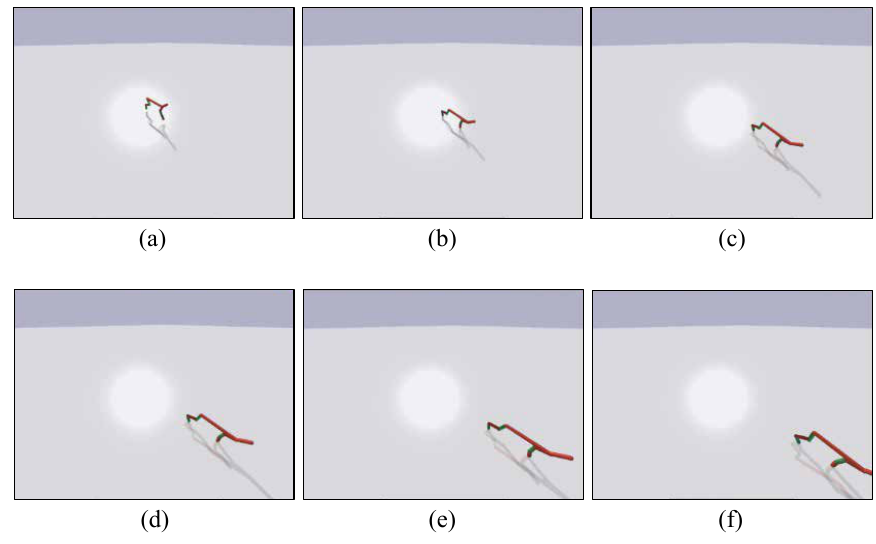
Figure 10. The visualized training result.The subgraphs ( a – f ) are captured serially during the walking task of the trained HalfCheetah. The trained HalfCheetah is able to walk forward stably.